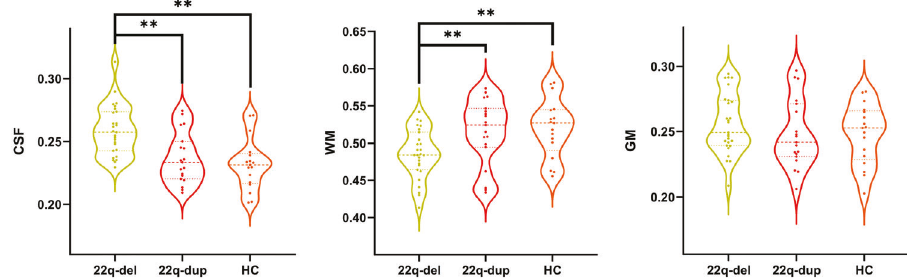
Fig. 2 Macrostructural volumetric measures across groups. Group comparison for relative cerebrospinal fl uid volume (CSF), relative white matter (WM) volume, and relative gray matter (GM) volume between 22q11.2 deletion carriers (22q-del), 22q11.2 duplication carriers (22q- dup), and healthy controls (HC). 22q-del had signi fi cantly higher CSF volume and lower WM volume relative to 22q-dup and HC. GM volume did not signi fi cantly differ between